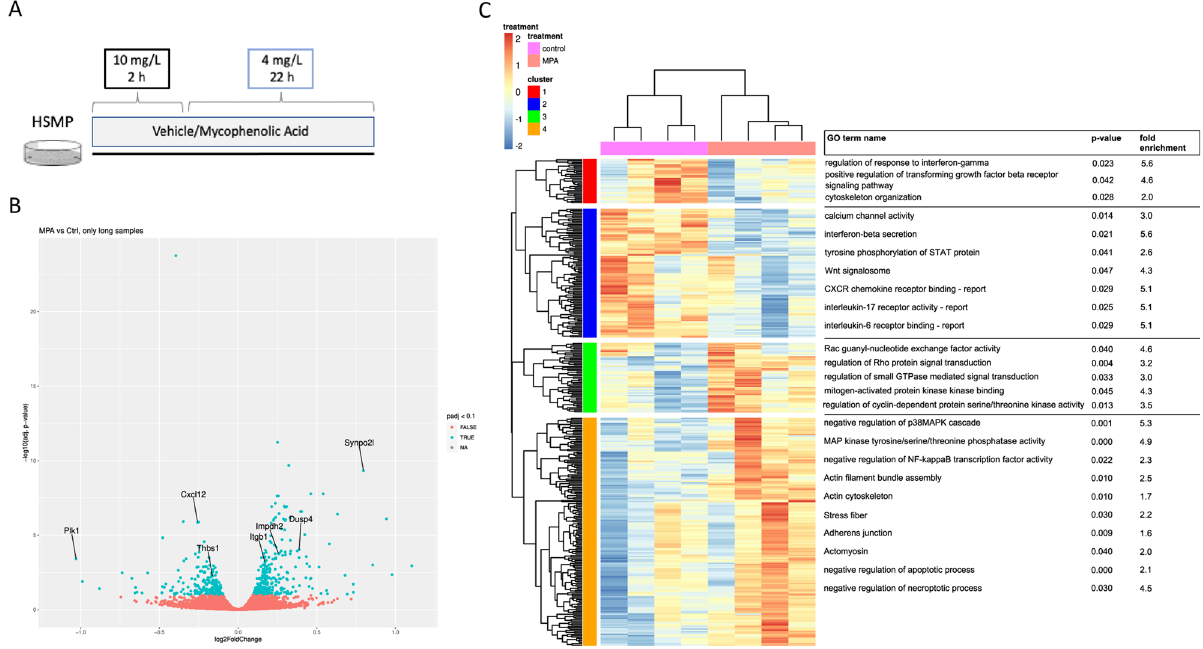
Figure 1. Treatment with MPA leads to changes in the transcriptome of podocytes. ( A ) Conditionally immortalized podocytes were differentiated treated with either Vehicle or Mycophenolic Acid (MPA) for 24 h and subjected to RNAseq analysis. ( B ) Volcano Plot visualizing the effects of MPA on the transcriptome of podocytes. Blue, adjusted p -value (padj) < 0.05; red, padj > 0.05. MPA treatment resulted in 130 significantly downregulated and 221 significantly upregulated genes. ( C ) Genes were sorted into a heatmap according to their z-score transformation value, resulting in four clusters. Cluster 1, red, downregulated genes. Cluster 2, blue, highly downregulated genes. Cluster 3, green, upregulated genes. Cluster 4, orange, highly upregulated genes. ( B ) Clusters were subjected to a Gene Ontology (GO)-term enrichment analysis. Important significantly enriched terms are summarized for each